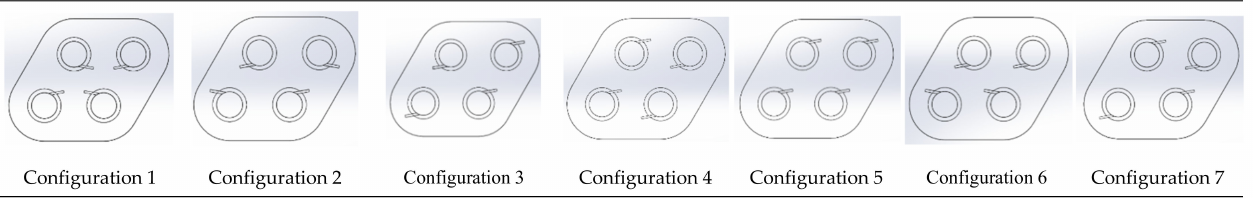
Figure 11. Quad-vortex array grippers with different inlet configurations.